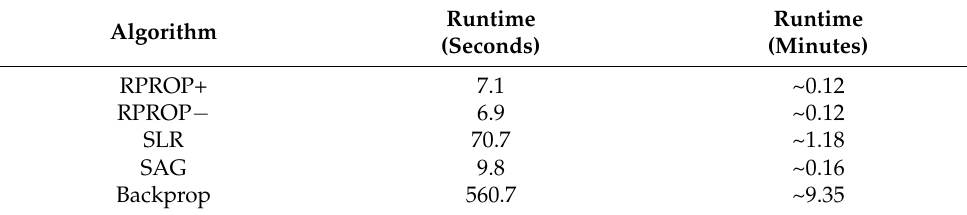
Table 6. ANN algorithms’